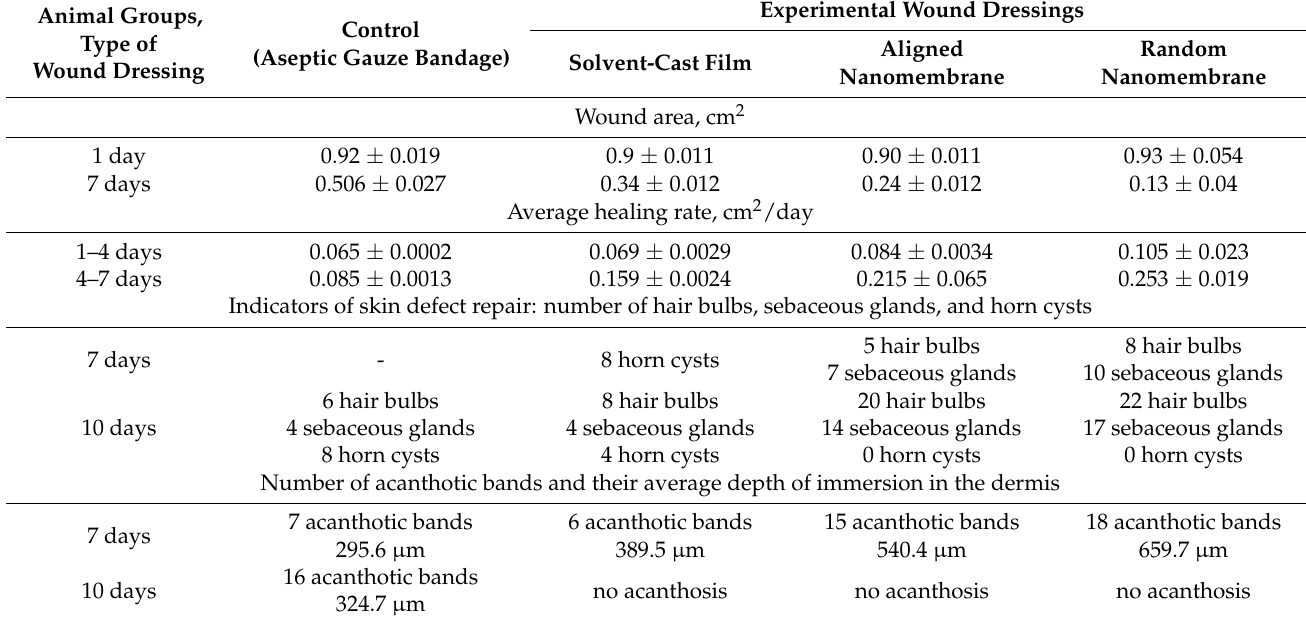
Table 5. Dynamics of healing of skin defects when using wound dressings made of copolymer